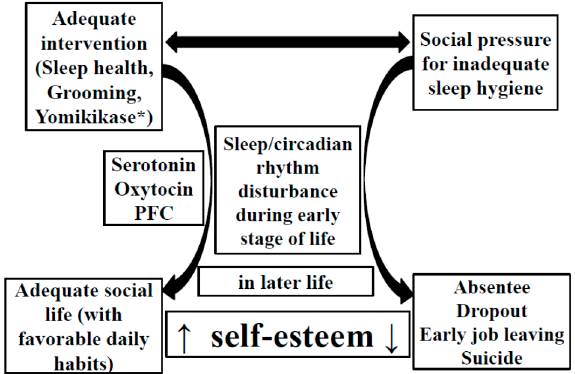
Figure 1. Proposed relationship between sleep hygiene, daily habits, neuronal elements, and self-esteem. Adapted from Kohyama [7] Expert. Rev. Neurother. 2014 , 14 , 745. Copyright © 2014 with permission of Expert Review of Neurotherapeutics. * Yomikikase refers to a Japanese phrase, meaning to read a book to another person [10]. Yomikikase is reported to activate the limbic structures of children [11] and increase the frontal cerebral blood flow of the reader [12].